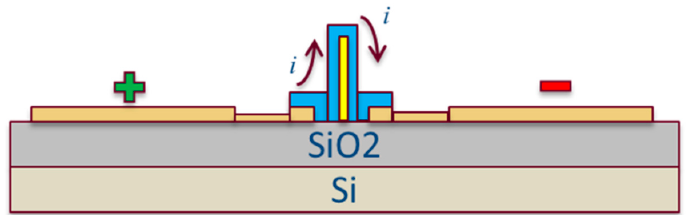
Figure 2. Schematic of the device structure of the UV and gas sensor. A vertical dielectric core (HSQ) is surrounded by infiltrated polymer (SU-8) that connects two electrodes ( + and − ), forcing the current ( i ) to go up and over the dielectric core.